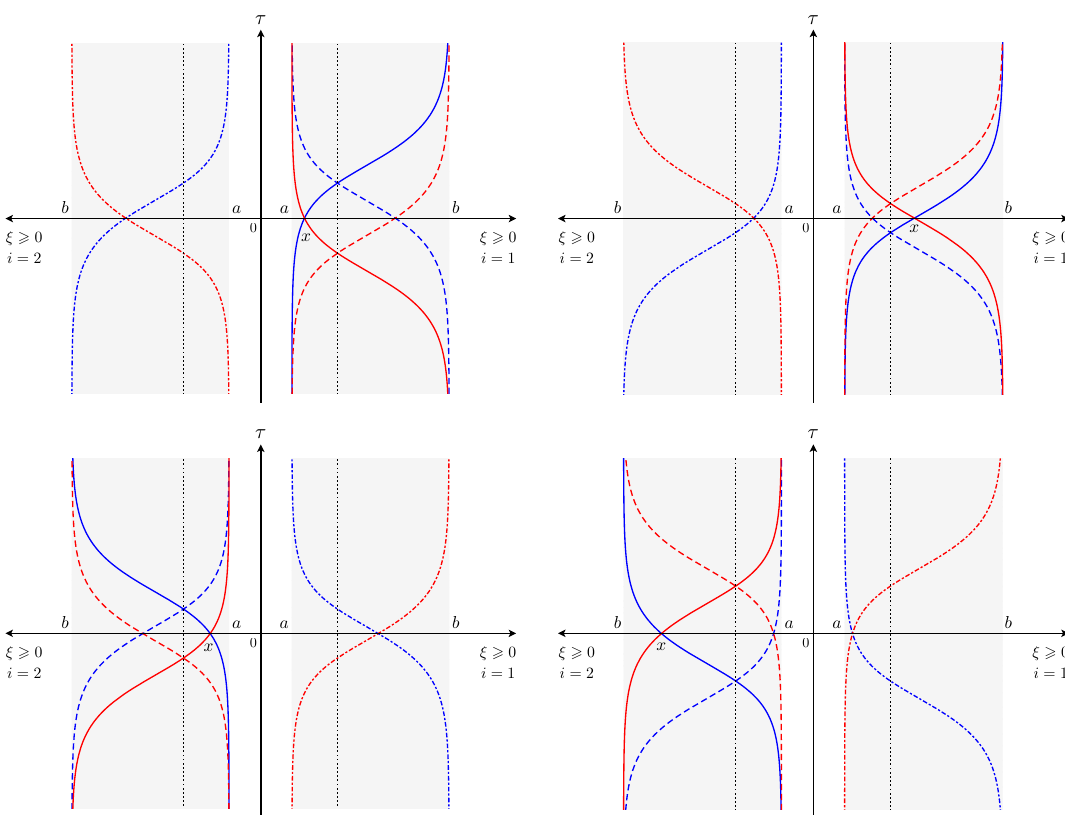
Figure 2 . Modular evolutions of the arguments of the fields mixed by the modular flow in the r.h.s’s of (5.13), for a point ( x, i ) (solid lines) and its conjugate points (˜ x, i ) (dashed lines) and (˜ x, j 6 = i ) (dashed-dotted lines), at τ = 0 . The blue and the red curves correspond to the first and √ to the second equation in (5.13) respectively. The vertical dotted lines identify the point ab in √ √ the two edges. Top panels: i = 1 with either x < ab (left) or x > ab (right). Bottom panels: √ √ i = 2 with either x < ab (left) or x > ab